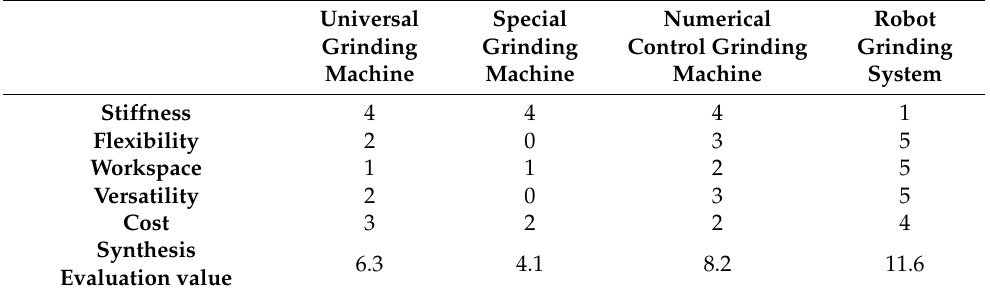
Table 1. Comparison of conventional grinding machines with robotic grinding systems.